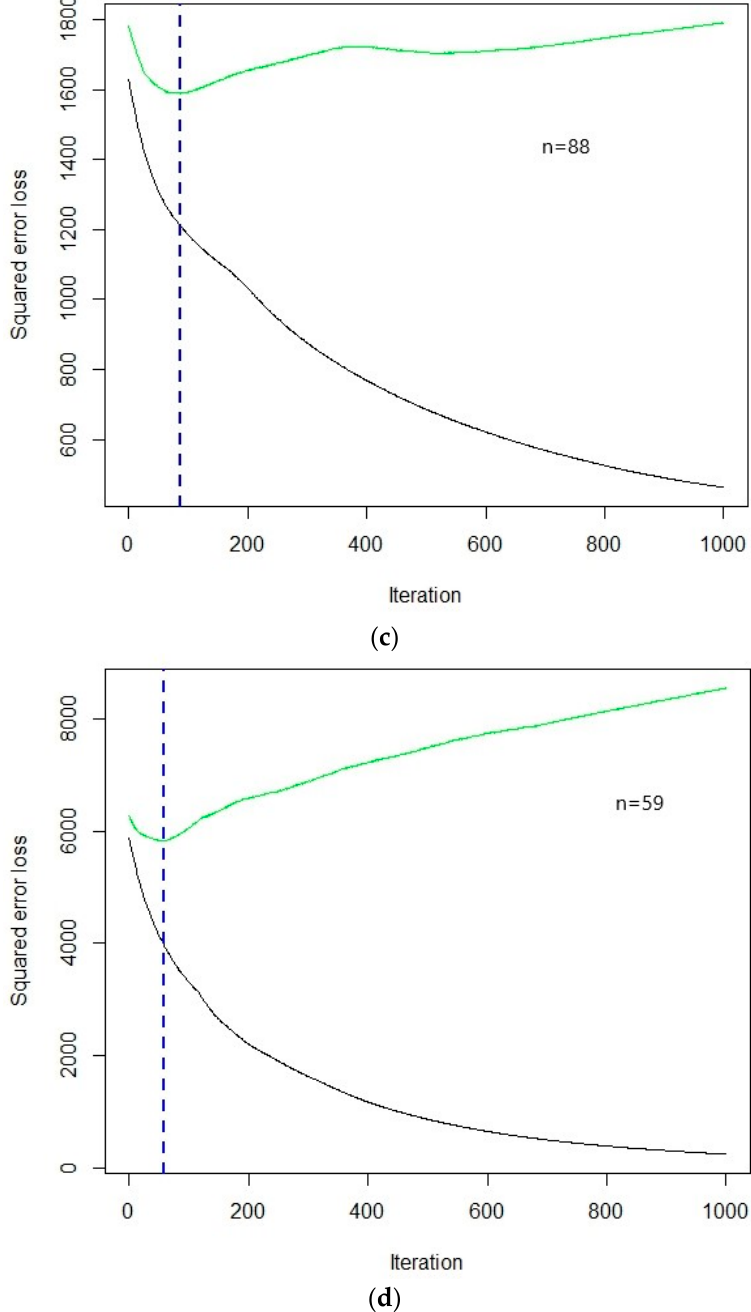
Figure 4. Example of a cross-validation model fitting with initial number of trees = 1000, interaction depth = 5, shrinkage = 0.01, and bag fraction = 0.5 for willingness to produce ( a ), willingness to rent ( b ), acreage commitment to produce ( c ), and acreage commitment to rent ( d ). (Number of trees: It represents the total number of trees to fit the model. This number is equivalent to the total number of iterations and the basic functions in the additive expansion. Overfitting can be a challenge if this number is too big. Interaction depth: It provides maximum depth of variable interactions. Shrinkage factor: It is a small positive number that controls the rate at which boosting learns. Default value is 0.01. A very small shrinkage factor always results better predictive performance of a model. However, smaller values would require many iterations. Bag fraction: It is the fraction of the training dataset that is randomly selected to propose the next tree in the expansion. Bag fraction introduces randomness into the model fit).